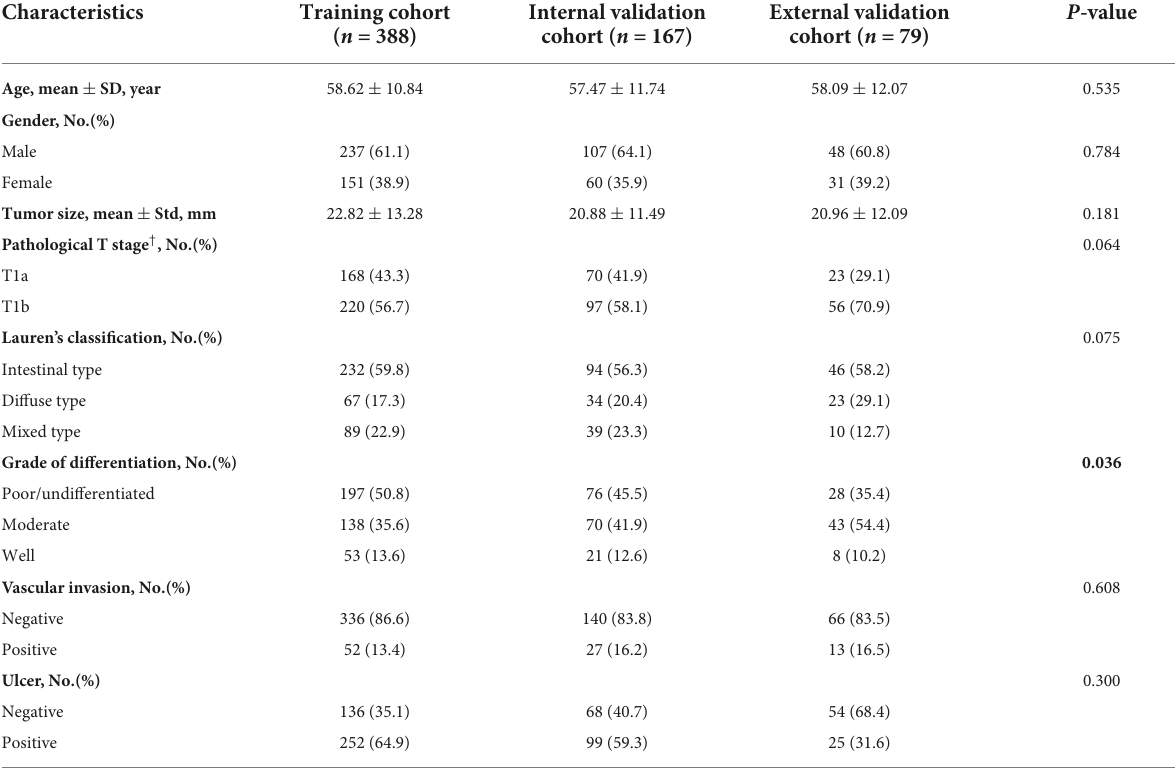
TABLE 1 Characteristics of early gastric cancer (EGC) patient included for classification